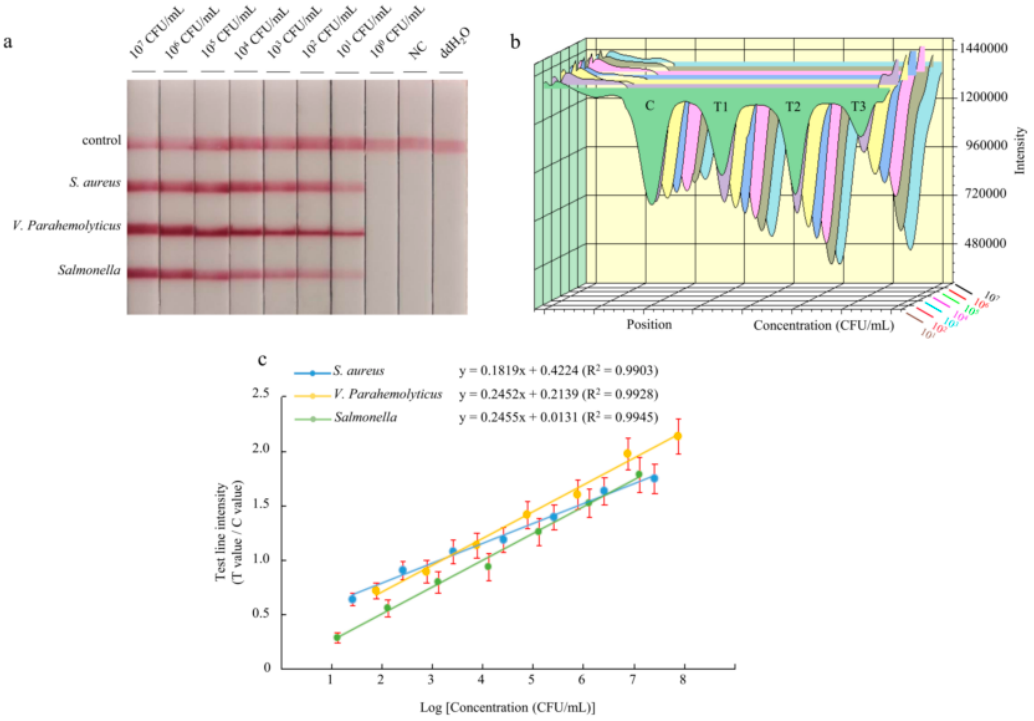
Figure 3. Reaction sensitivity of triplex LFD-RPA for the Staphylococcus aureus strain culture, Vibrio parahaemolyticus strain culture, and Salmonella Enteritidis strain culture. The amplified products could be observed by the naked eye by using a lateral flow dipstick ( a ). The intensity ( b ) was used for quantitative analysis, and it shows a linear correlation ( c ) with the concentration of pure cultures. The test line intensity was the ratio of the reflected light for the test line and control line.